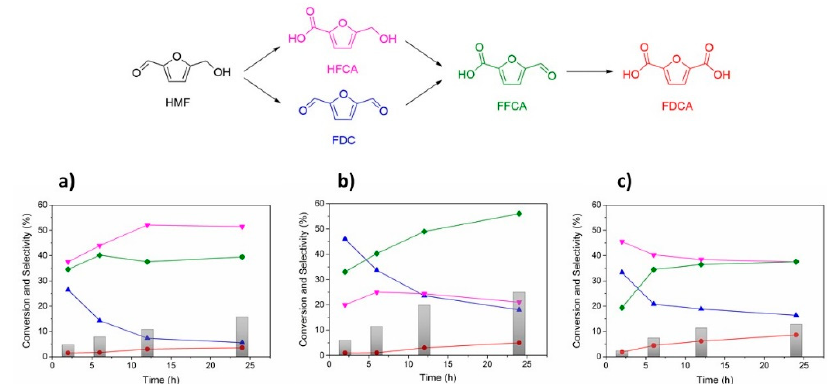
Figure 5. HMF oxidation in the aqueous phase in the absence of base using Au x Pd y @SiTi catalysts: conversion and selectivity as a function of time: ( a ) Au@SiTi, ( b ) Au 1 Pd 1 @SiTi, ( c ) Pd@SiTi; selectivity to: ● FDCA, ▲ FDC, ▼ HFCA, FFCA. Aqueous solution of HMF (30 µmol), substrate/metal = 18 (mol/mol), O 2 (1 bar), 100 °C, 600 rpm.